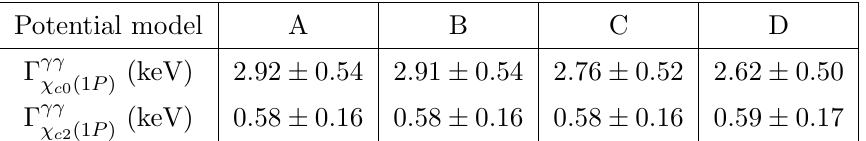
Table 7 . Results for the cross sections (cid:27) ( e + e (cid:0) ! (cid:31) cJ (1 P )+ (cid:13) ) at models described in section